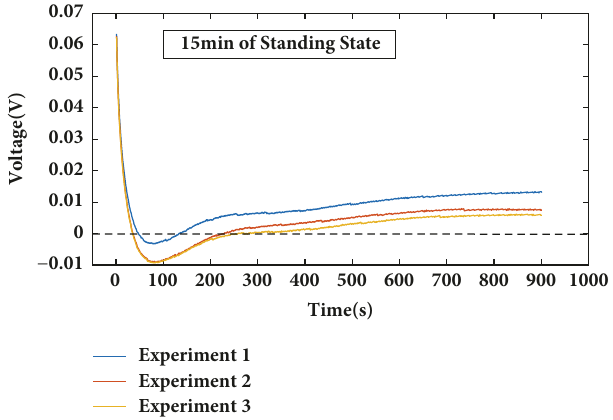
Figure 12: Comparison of the error between the model simulations and experiments measurements at self-healing time of 15